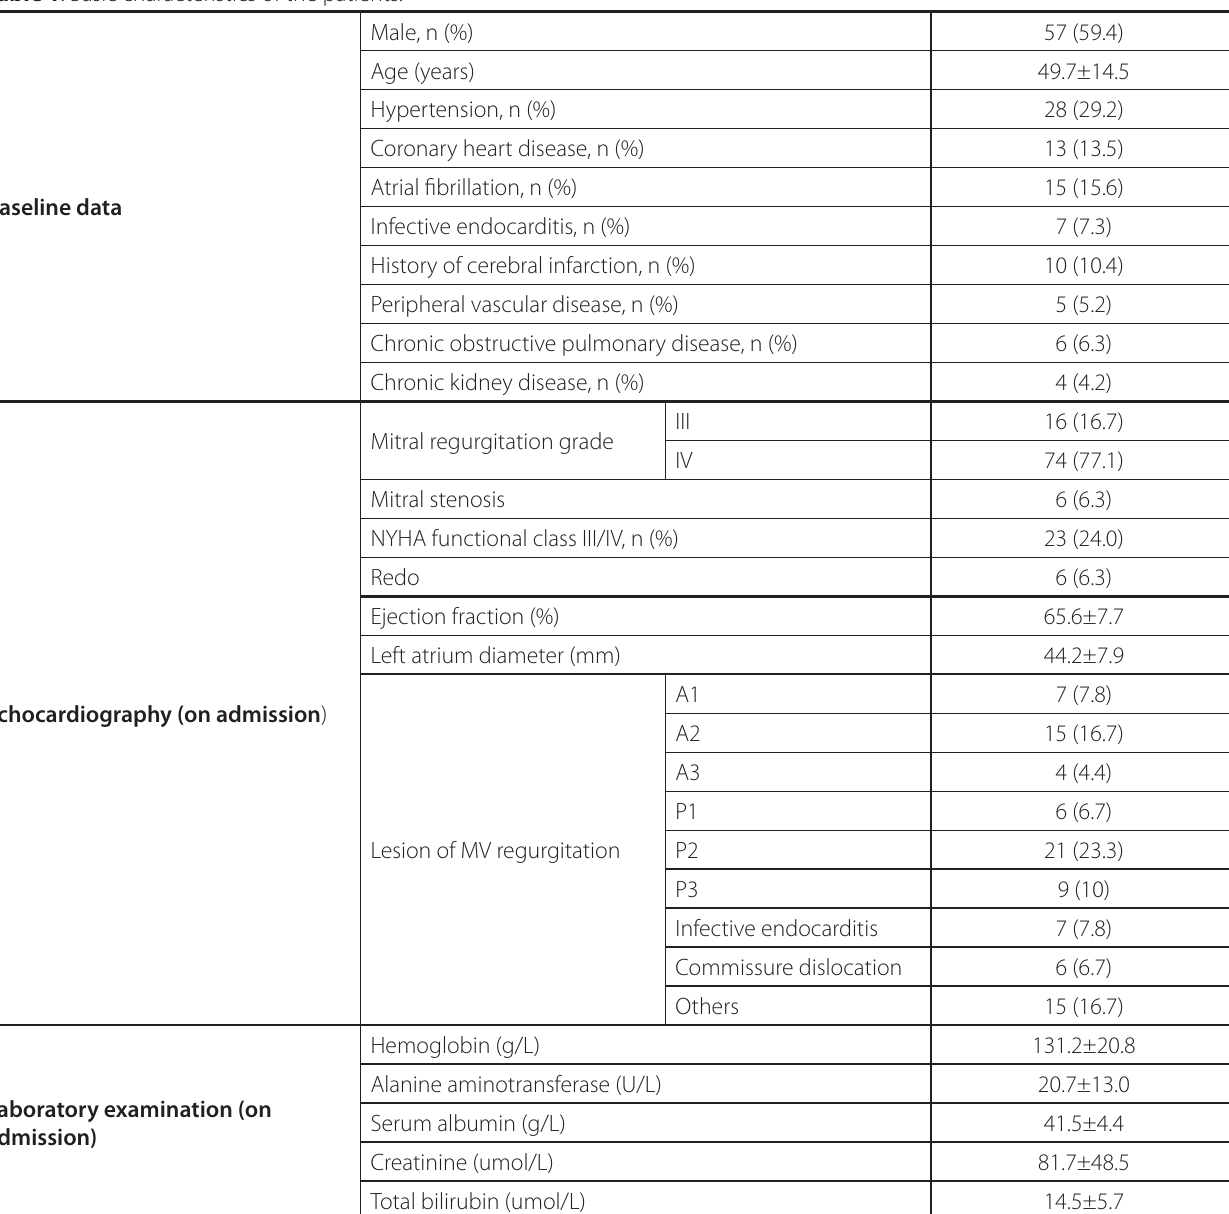
Table 1 . Basic characteristics of the